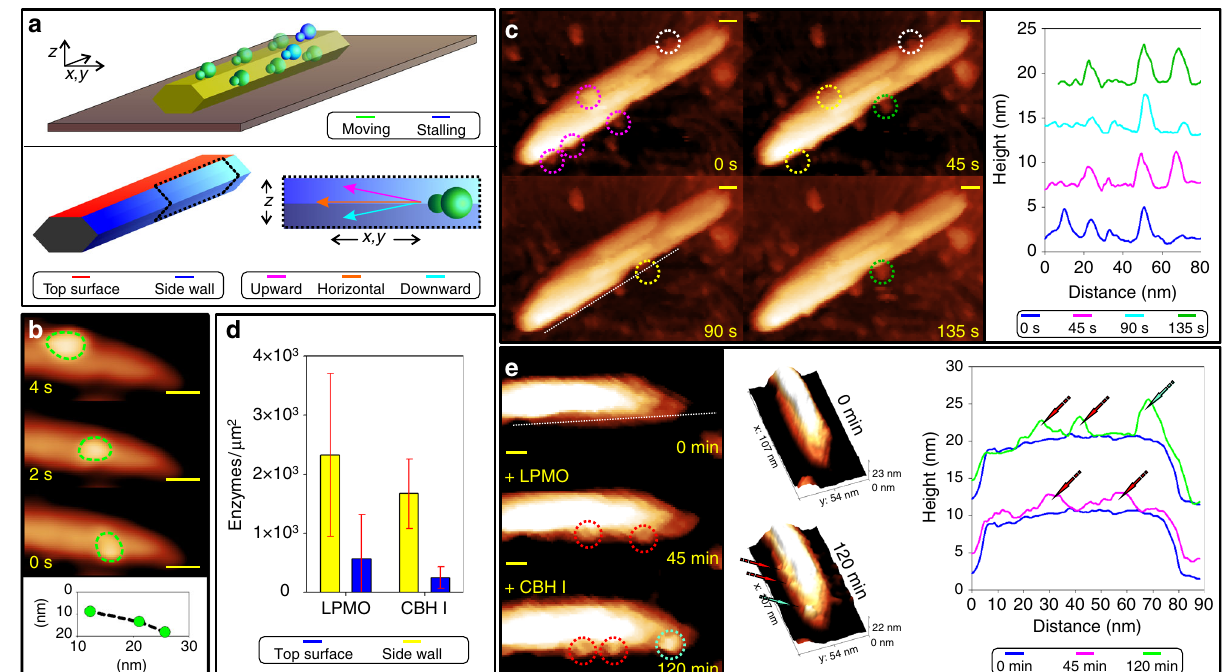
Fig. 1 Single-molecule observations on cellulose nanocrystals. a Schematic of an idealized cellulose nanocrystal adsorbed to graphite and terminology for enzyme localization and movement on the cellulose. b Real-time AFM observation of CBH I molecules (outlined in color) on a cellulose nanocrystal. Images were recorded at 0.5 s − 1 and the enzyme center was tracked to obtain the velocity data. The image sequence was taken from Supplementary Movie 2. c C1 oxidizing LPMO molecules on a cellulose nanocrystal visualized in real time (1.3 AFM frames min − 1 ). Colored frames indicate enzymes present initially (magenta), adsorbing (green), or desorbing (vacated position; yellow) in the relevant timespan. The height pro fi le along the dashed line shows multiple stationary LPMO molecules bound on the side wall of the cellulose nanocrystal. One LPMO molecule, circled white, was not included in the analysis, for it failed the rigorous height criterion. d Individual enzyme adsorption to the side walls (yellow bars) and to the top (blue bars) surface of cellulose nanocrystals. Mean values of enzymes-adsorbed/surface area of cellulose nanocrystal are shown together with the corresponding standard error. e Visualization and cross-sectional analysis of LPMO (circled red, red arrows) and CBH I (circled turquois, turquoise arrow) along the dashed line showed successive adsorption to the same cellulose nanocrystal. As enzymes differ in height (Supplementary Fig. 1), LPMOs ( ~ 2 nm) are clearly distinguished from CBH I molecules ( ~ 4 nm). All scale bars are 10